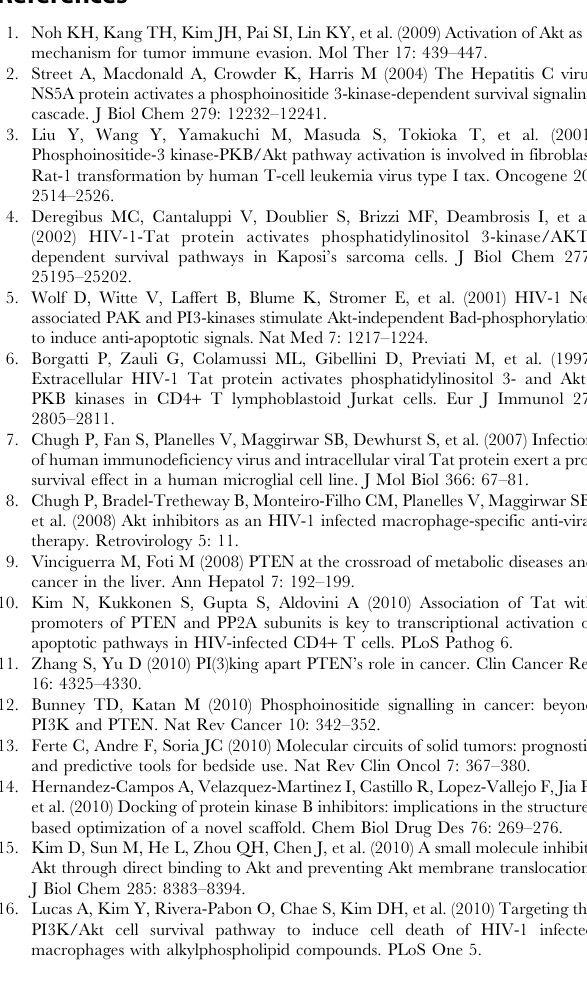
20 m M. The percentage cell death was plotted as mean and SEM for the three compounds. (TIF) Data S3 PIP3 standard curve and data. ( A ) Western dot blot analysis was done to generate a standard curve using 0.5, 1, 2, 4 and 5 pmoles of PIP3. Data were plotted to find the slope and y- intercept. ( B ) One representative data set is shown for lysates of Tat-expressing CHME5 cells treated under conditions. LPS/CHX treatment was 50 m g/ml LPS and 10 m g/ml cycloheximide. Lancemaside A1 (LA), Arctigenin (AR), Compound K (CK) and Wortmannin (WM). Table S1 Western blots were analyzed. Data was normal- ized to either total proteins (Akt and GSK-3 b ) or b -actin (p-mTor, pBad, p-PDK1 and PTEN). Data of means and standard deviations from the western blot analysis are shown. Control lanes were set to 1.00. LPS is the positive control. Changes in intensities are shown for the different drug treatment